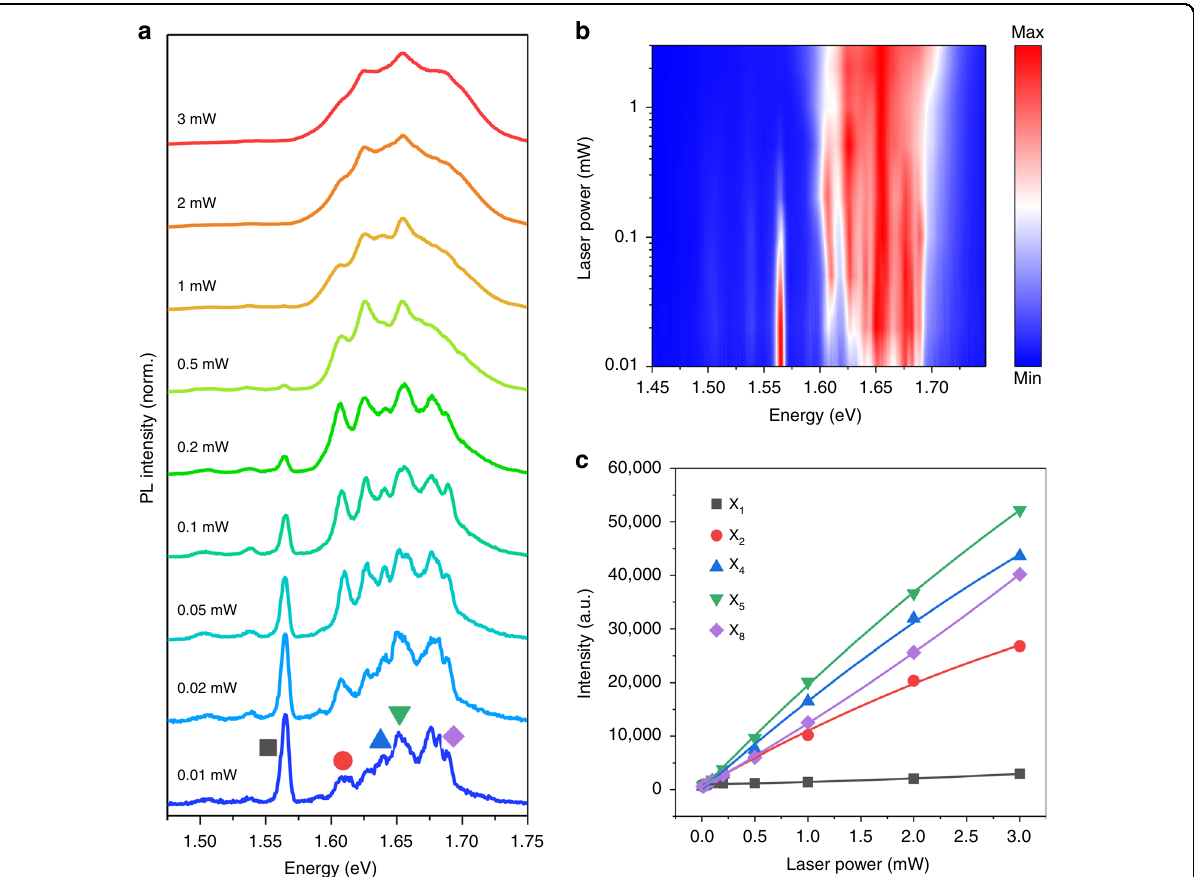
Fig. 4 Power-dependent PL properties of WSe 2 /WSe 2 twisted homobilayer. a The normalized PL spectra of different excitation powers range from 0.01 to 3 mW, the excitation photon energy is 2.33 eV, and the energy resolution is 3 meV. b The normalized PL spectrum of T-HB as a function of power (0.01 mW~3mW), and the data come from Fig. 4a. c The geometric shapes of different colors correspond to the positions of different energy peaks, from Fig. 4a. The PL intensity of different peak positions under different excitation